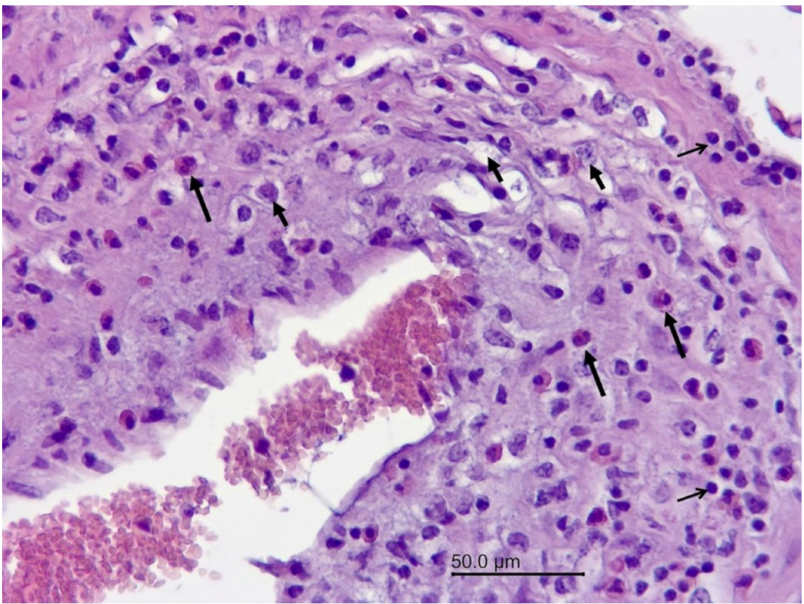
Figure 3. Wapiti, case 1, brain, histopathology, HE, × 200. Blood vessel with numerous inflammatory cells in the wall–eosinophils (long arrows), macrophages (short arrows), and lymphocytes (open arrows) (mixed cell vasculitis).